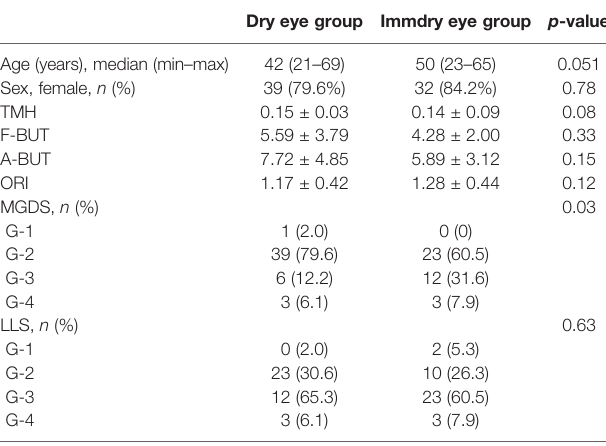
TABLE 2 | Ocular surface parameter assessment of the